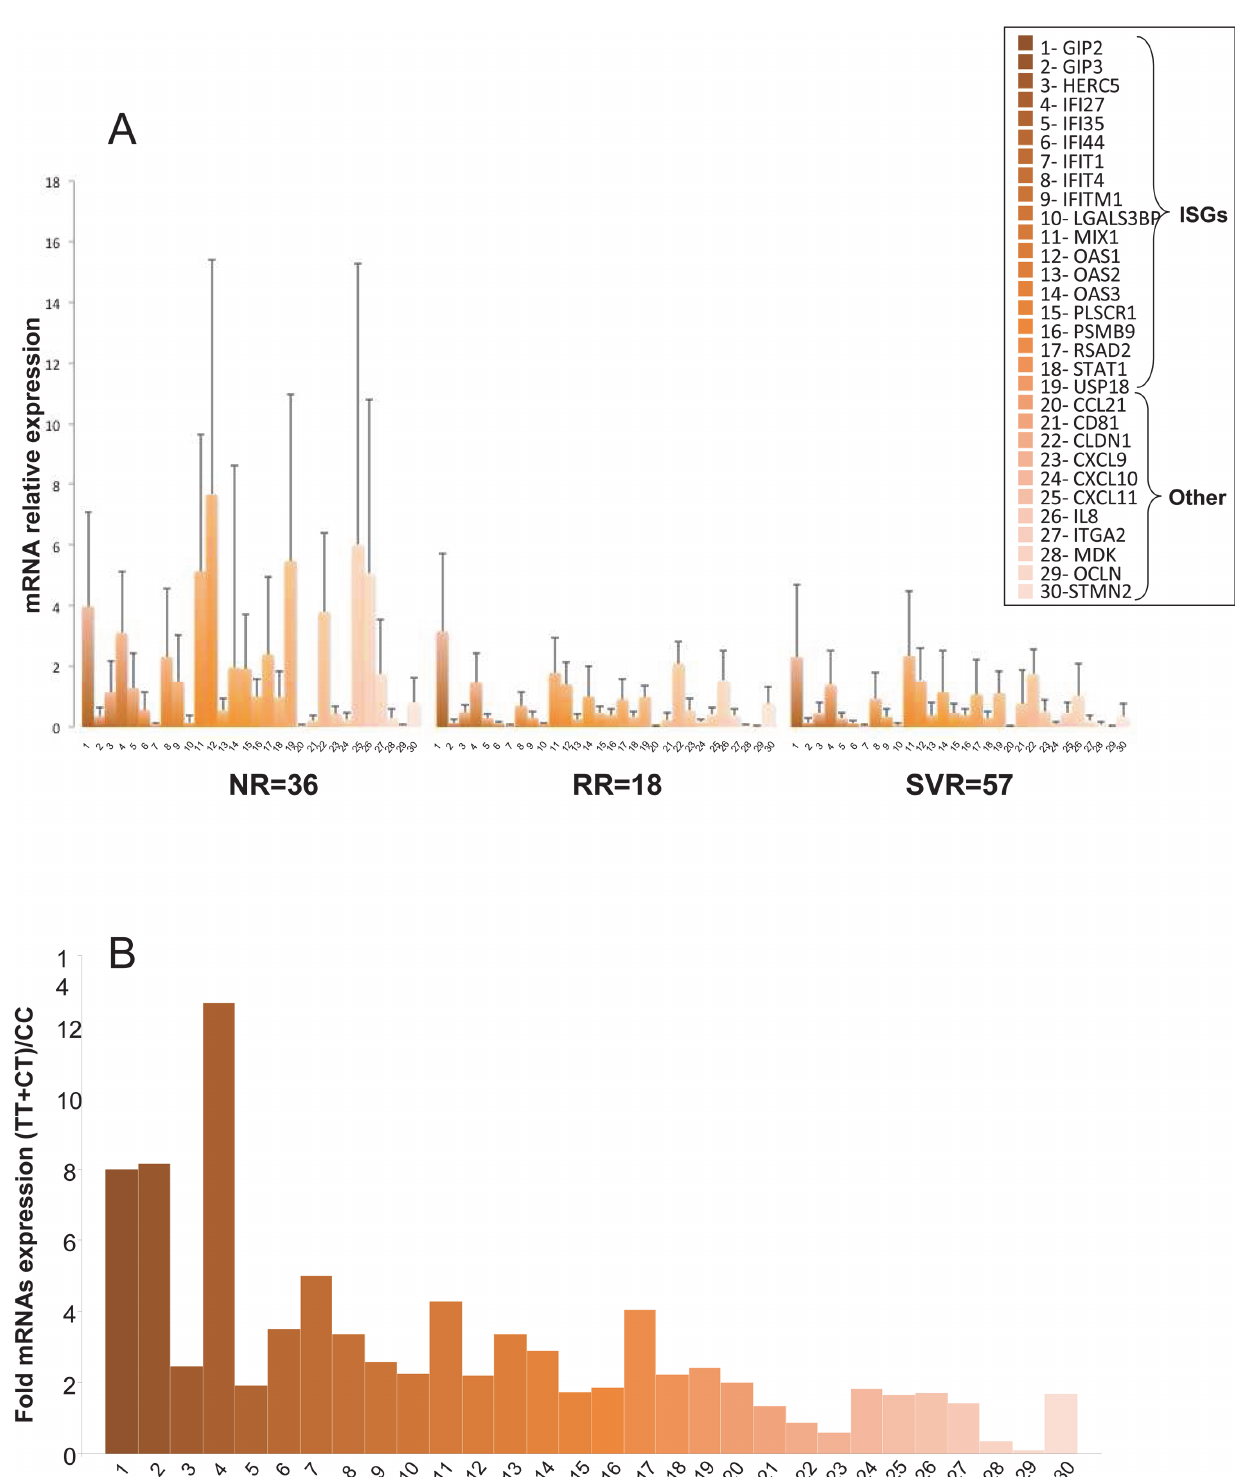
Fig 4. Differential mRNAs expression in NRs and SVRs prior to treatment. 4A- The hepatic expression of 25 mRNAs was assessed in the total group of patients by RT q-PCR. The Δ Cp ( Δ Cp t = 2 Δ Cpsample ) value was calculated for each mRNA expression and normalized to the Δ Cp value of RPLP0 in each liver biopsy. The histograms represent the mean value of the expression of mRNA in NRs, SVRs and RRs. The expression values were compared by non- parametric test. 4B- High expression of ISGs is associated with IFNL3 TT genotype. The intra-hepatic expression of 25 mRNAs was analyzed by RT-qPCR